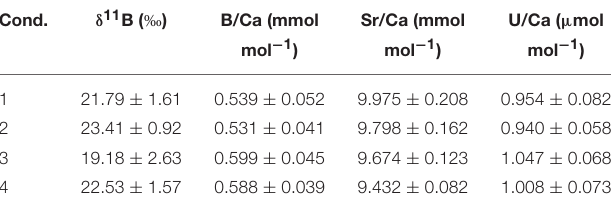
TABLE 4 | Summary of mean primary polyp juvenile coral analyses in each experimental condition. Cond.